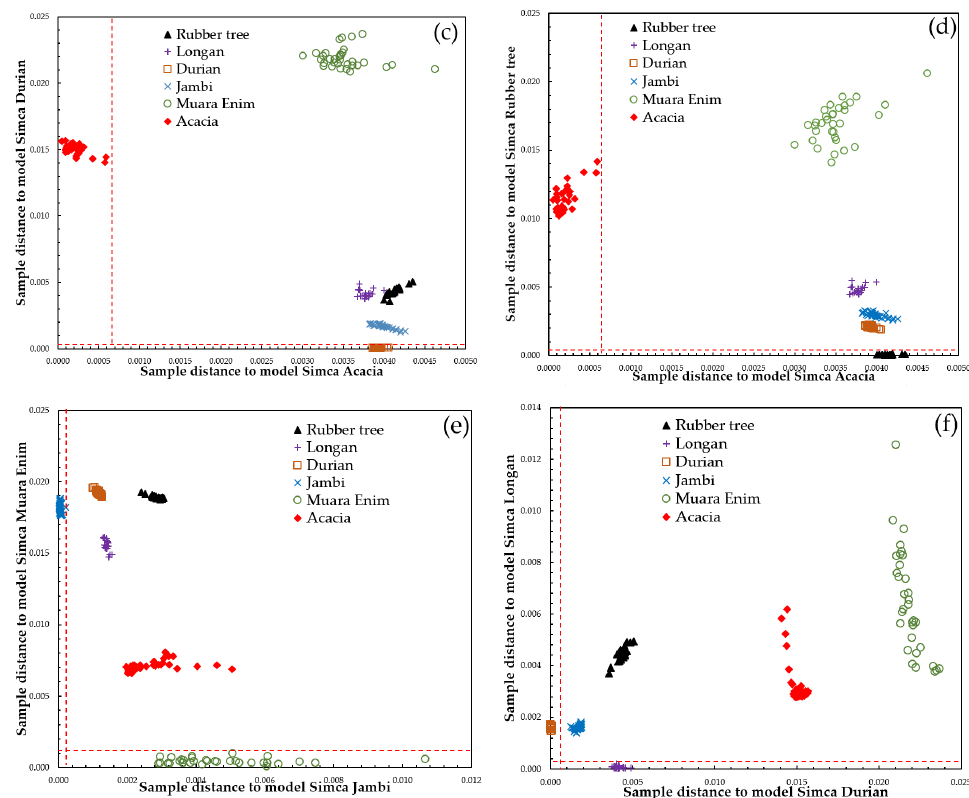
Figure 7. Cooman’s plot of the classification result of six pairwise SIMCA models for prediction sample sets using SIMCA models developed in each class using pre-processed spectral data over the range of 250–400 nm (acacia versus Jambi ( a ), acacia versus longan ( b ), acacia versus durian ( c ), acacia versus rubber tree ( d ), Jambi versus Muara Enim ( e ), and longan versus durian ( f )). (the significance level for the Cooman’s plot is 95%). (Rubber tree: black triangle; longan: purple plus; durian: brown open squares; Jambi: blue cross; Muara Enim: green open circle; acacia: red dia- monds).